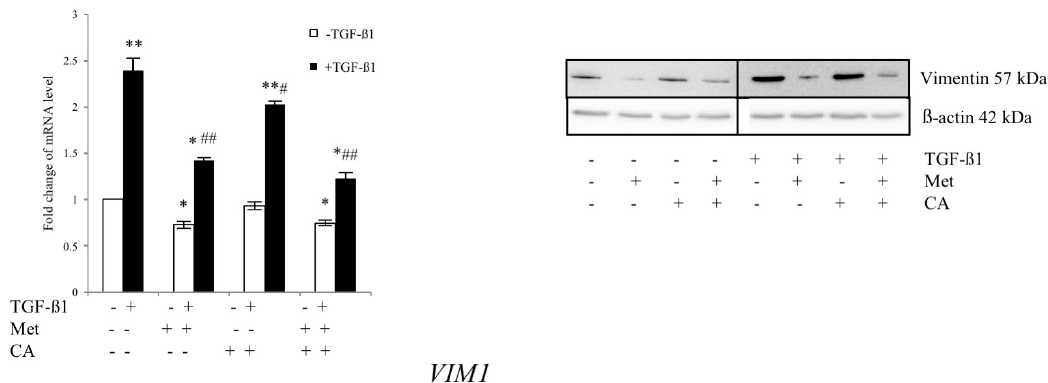
Figure 7. Met suppress the expression of mesenchymal marker Vimentin in HTB-35 cells. The cells were treated with TGF- β 1 (10 ng/mL) plus CA (100 μ M) and/or Met (10 mM) for 48 h. In parallel, cell cultures were treated with tested compounds but were grown without addition of TGF- β 1. The RNA expression was determined with qPCR analysis using the 2 −ΔΔ C t method ( GAPDH was a reference gene). The protein levels of Vimentin were detected by western blot (right panel). Immunoblots were